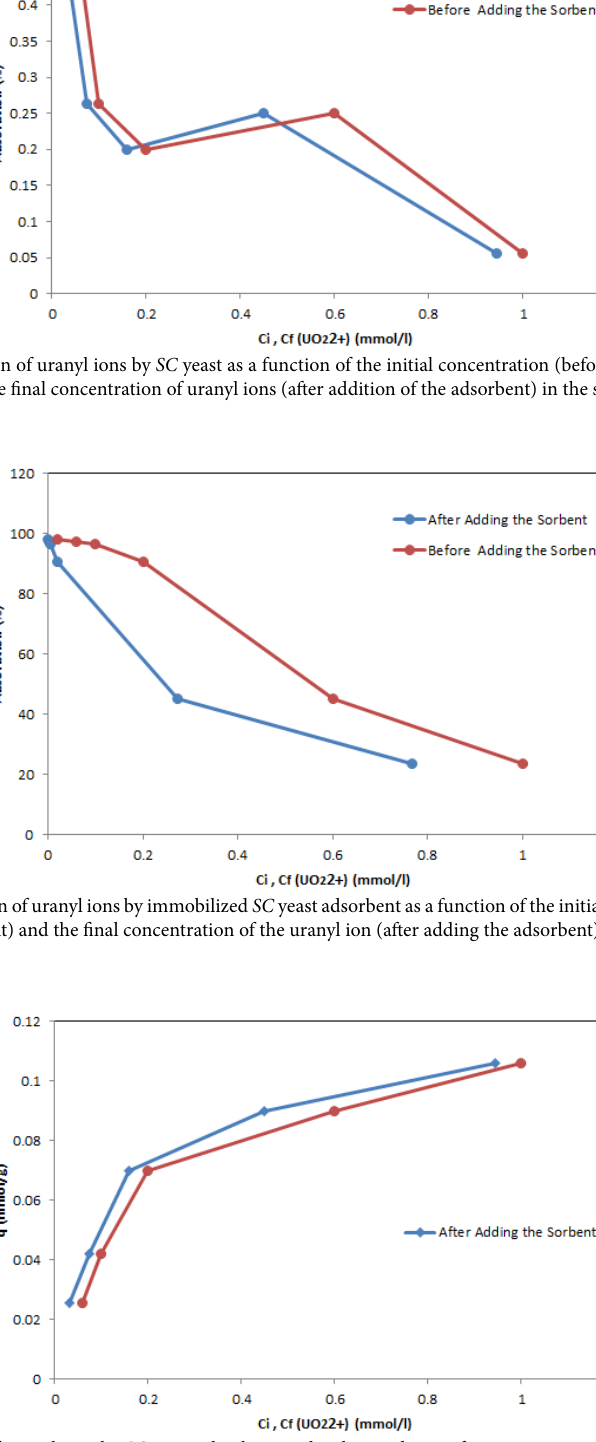
Fig. 13. Equilibrium data of uranyl ions by SC yeast adsorbent under the condition of PH = 4.5, temperature of 25 ° C, 50 mL initial Fig. 13 . volume of solution, 20 mg immobilized SC yeast adsorbent and equilibrium time of 3.5